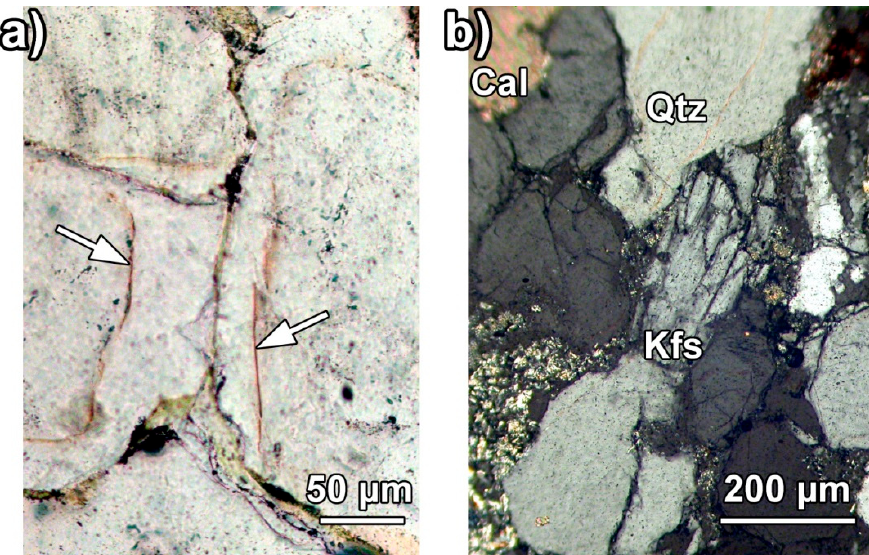
Figure 12. Petrographic features of the sampled MdT-25992 frieze. ( a ) PPL micrograph exhibiting iron oxide pore-lining (arrows) delimiting quartz clasts and quartz cement. ( b ) XPL micrograph presenting quartz (Qtz), calcite (Cal), and K-feldspar (Kfs) clasts, the latter appear fractured due to mechanical compaction.